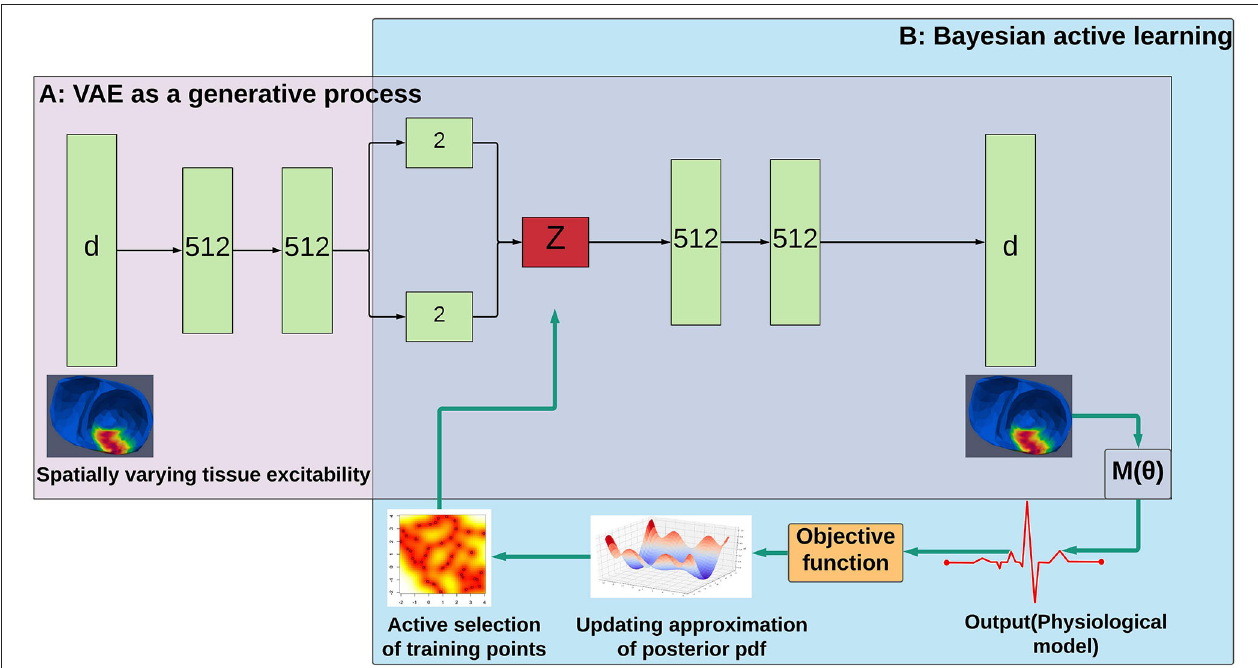
FIGURE 1 | Workflow of the presented method. (A) A generative model of HD spatially varying tissue excitability of the 3D heart is trained offline. (B) The resulting generative model is embedded into Bayesian active learning to approximate the posterior pdf of model parameters using a small number of intelligently selected training points guided by the acquisition function.